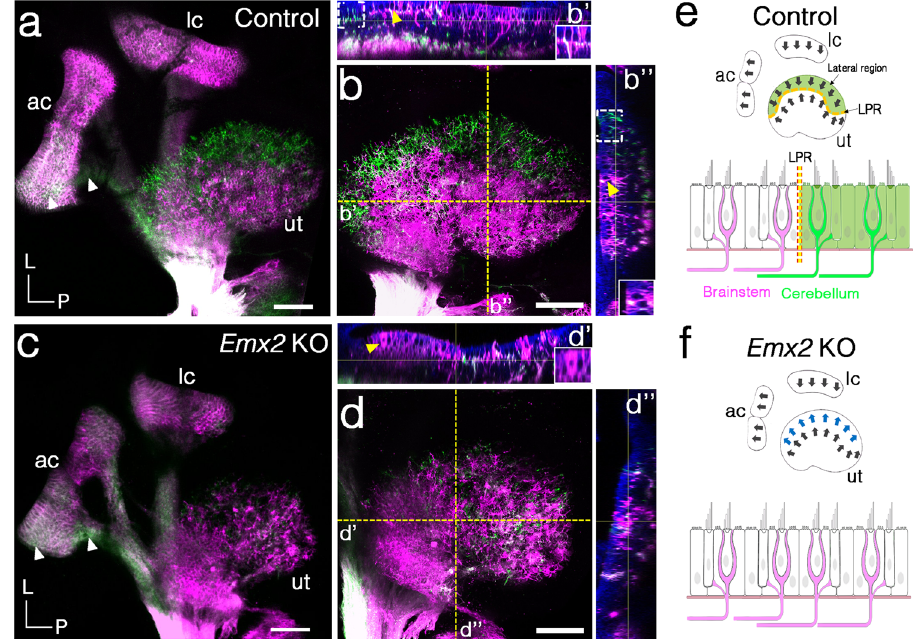
Fig. 2| Failureofcerebellarafferent neuronstoreach Emx2 KOmaculae.a – b ” , c – d ” Neuronal tracing with NeuroVue® Red (magenta)- and NeuroVue® Maroon (green)-soaked fi lterpapersinsertedintotherespectivebrainstemandcerebellum of hemi-sectioned heads of control ( a – b ” ) and Emx2 KO ( c – d ” ) at E16.5. b , d are higher magni fi cations of the maximum-intensity projection images of a , c . b ’ , b ” , d ’ , d ” are z -stack images of areas indicated with yellow dotted lines in b , d ,respectively.Incontrol,dyetracedfromthecerebellum(green)issegregated to the lateral region of utricle ( b ’ , b ” , white dotted bracket), whereas tracing from the brainstem is largely restricted to the medial utricle ( a , n =5). Dyes from both cerebellum and brainstem reached the sensory epithelium with some appeared